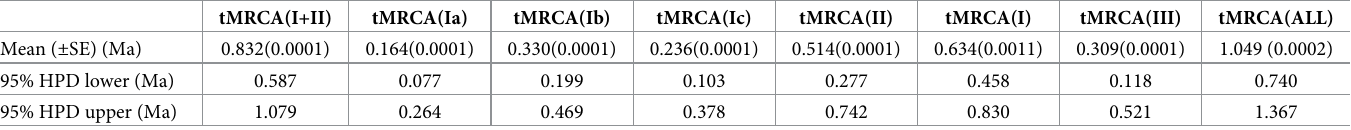
Table 3. Estimates of time since the most recent common ancestor (tMRCA; time scale in millions of years; standard errors are presented in parentheses) and 95% HPD estimates for clades/sub-clades for the main internal nodes of Aphyocypris normalis phylogeny (Fig 2) obtained using the cytb sequences based on a constant population model.